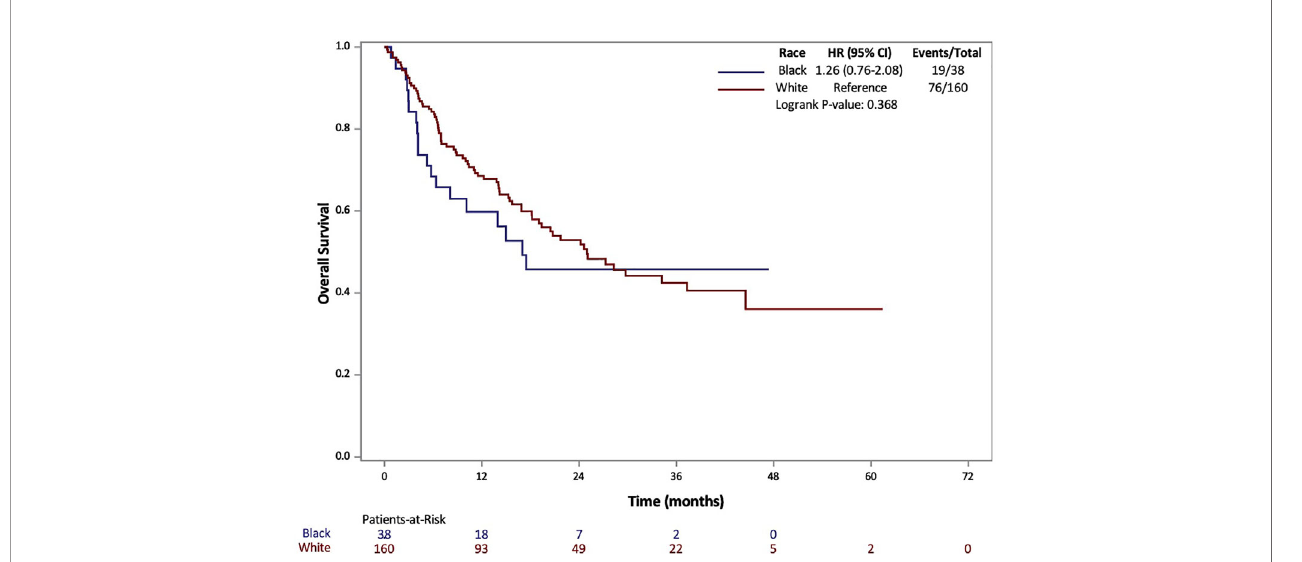
FIGURE 1 | Overall Survival (OS) of patients with metastatic RCC by race: African-American (black) and Caucasian (white).